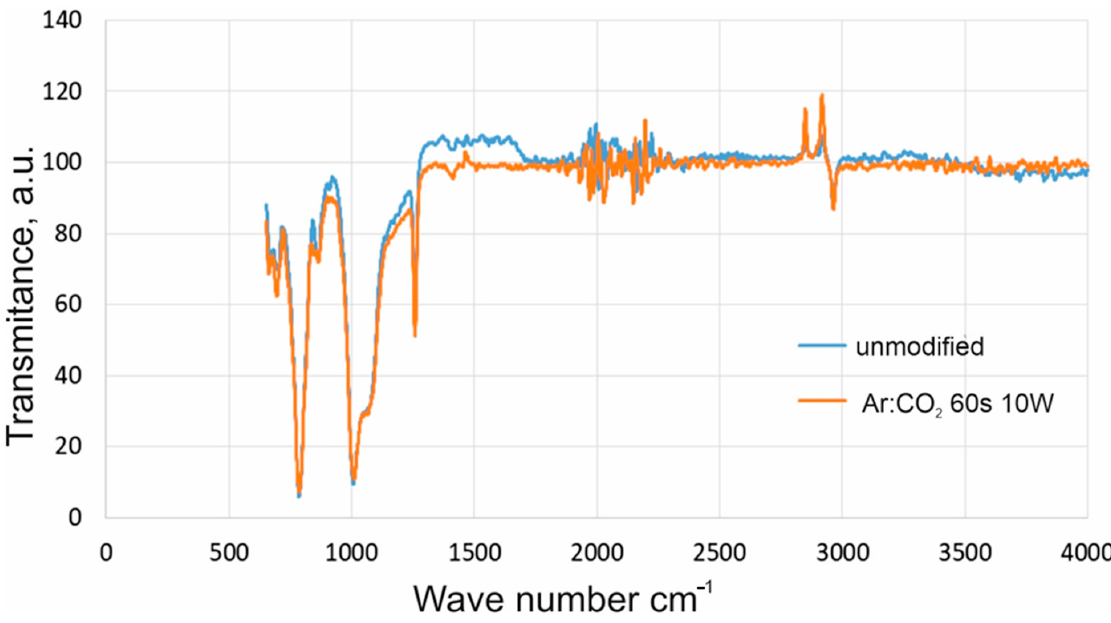
Figure 4. FTIR spectra of fresh and modified bonds in DBD silicone samples. Figure 5. FTIR spectra of fresh and modified bonds in DBD silicone